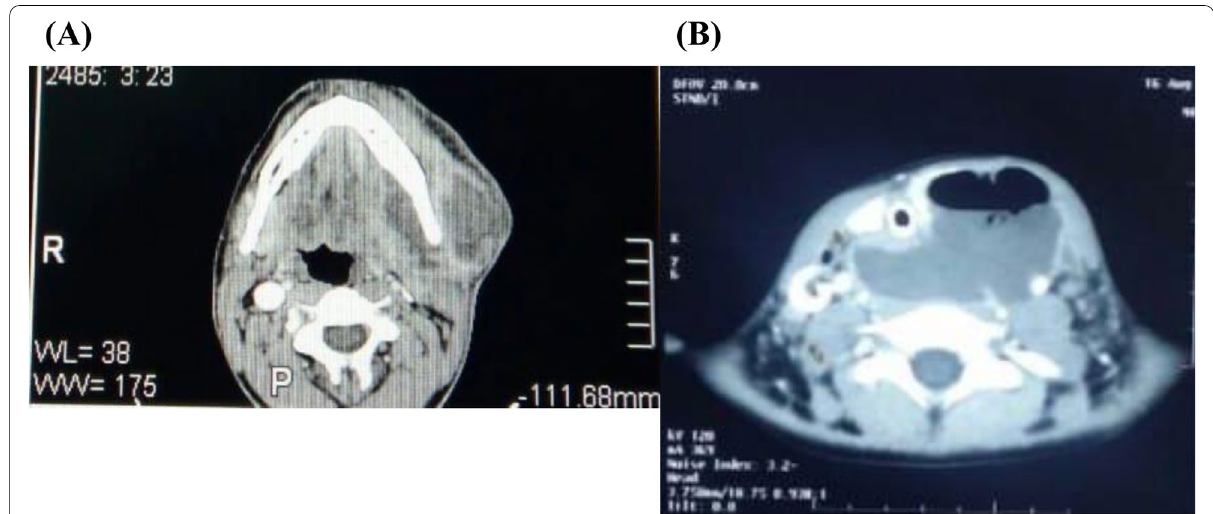
Fig. 1 Contrast-enhanced CT of the neck demonstrated. A An abscess in the left submandibular space. B Large sized retropharyngeal space